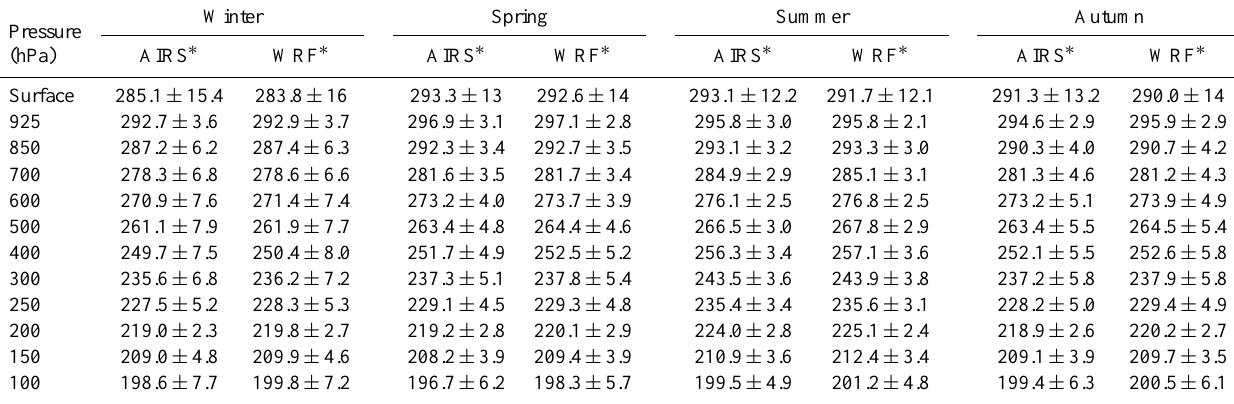
Table 3. Domain-wide average and standard deviation of AIRS and WRF-Chem temperature values (K) at the surface and at different pressure levels between 925 and 100hPa during the winter, spring, summer and autumn seasons of the year 2008.